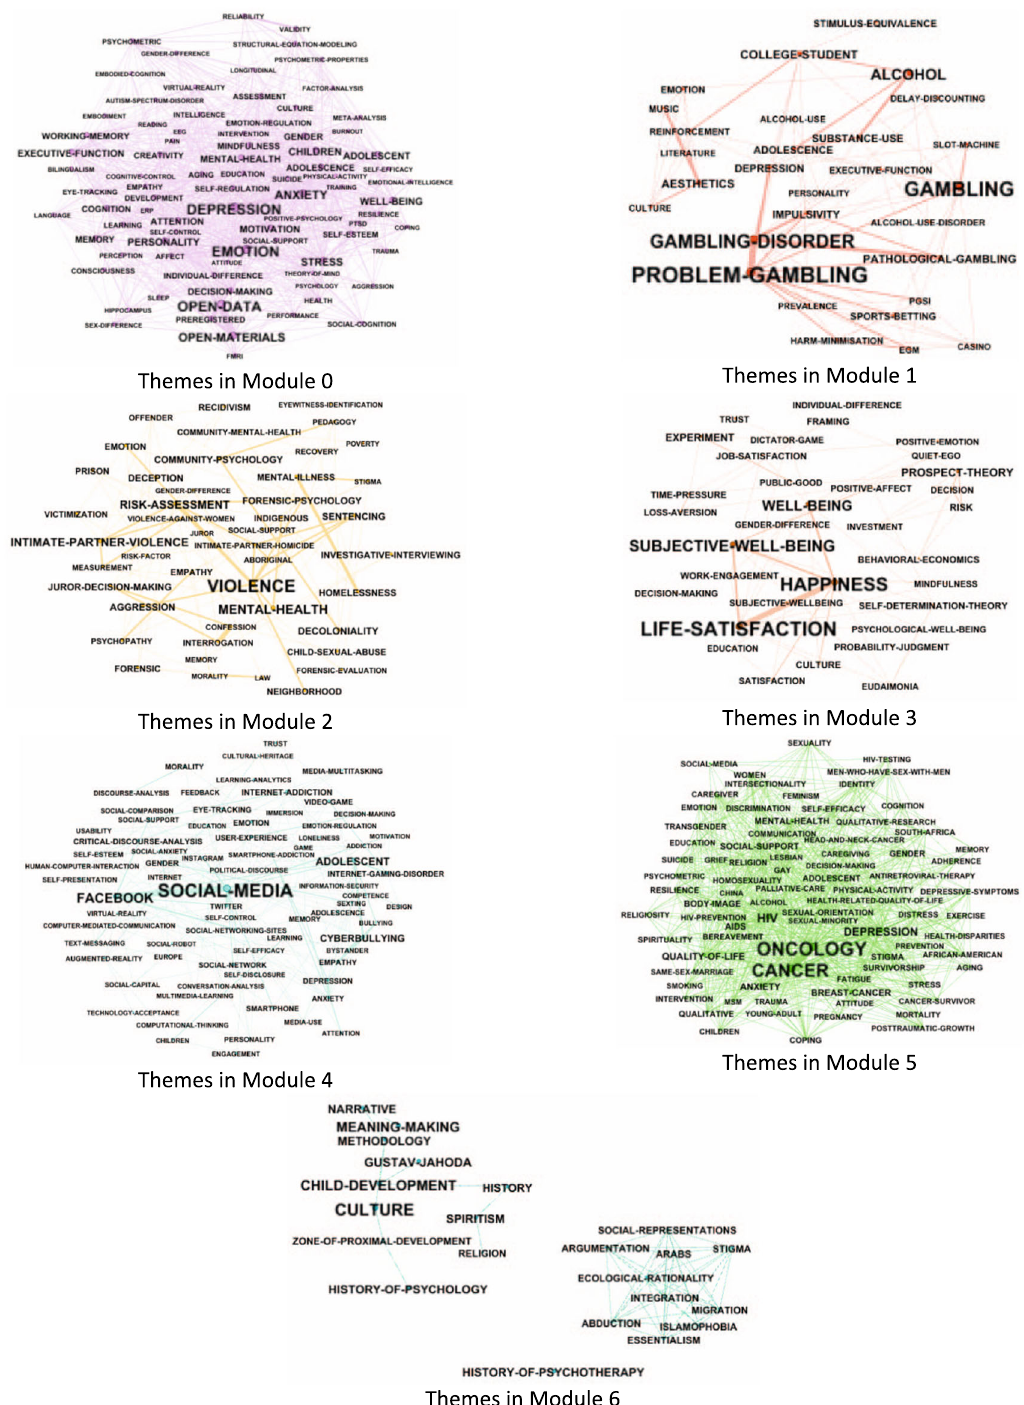
Fig. 4 Keywords found in each module identi fi ed in the 2018 citation network. The size of the node re fl ects the number and weight of the degree (i.e., larger nodes had many connections and highly weighted connections). The thickness of the connection indicates the weight of the connection (i.e., connected nodes with thick lines co-occurred many